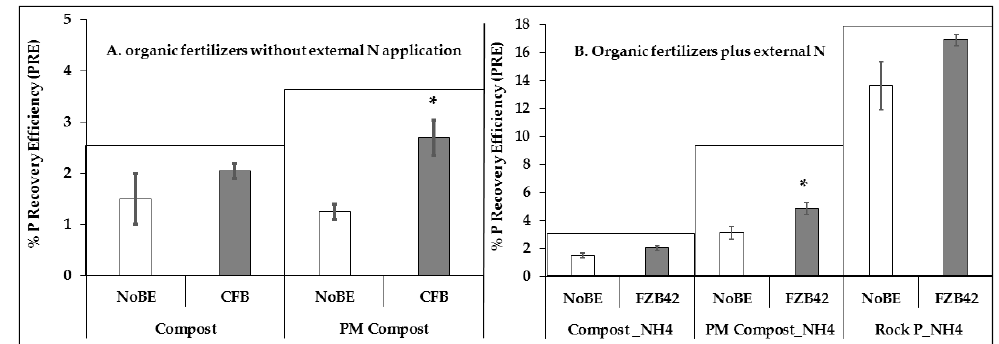
Figure 8. Phosphorus recovery efficiency [41] in tomatoes from different organic and inorganic fertilizers in moderately alkaline soil pH 7.8 ( A ), and moderately acidic soil pH 5.6 without (NoBE) and with microbial inoculation ( B ); CFB = Combifector B FZB42 = Bacillus amyloliquefaciens FZB42, Compost_NH4 = Municipal waste compost + stabilized ammonium sulfate, PM-Compost_NH4 = Municipal waste compost + poultry manure + stabilized ammonium sulfate, Rock P_NH4 = rock phosphate + stabilized ammonium sulfate. * = significant t -test p < 0.05 compared with the non-inoculated control (NoBE) in each fertilizer